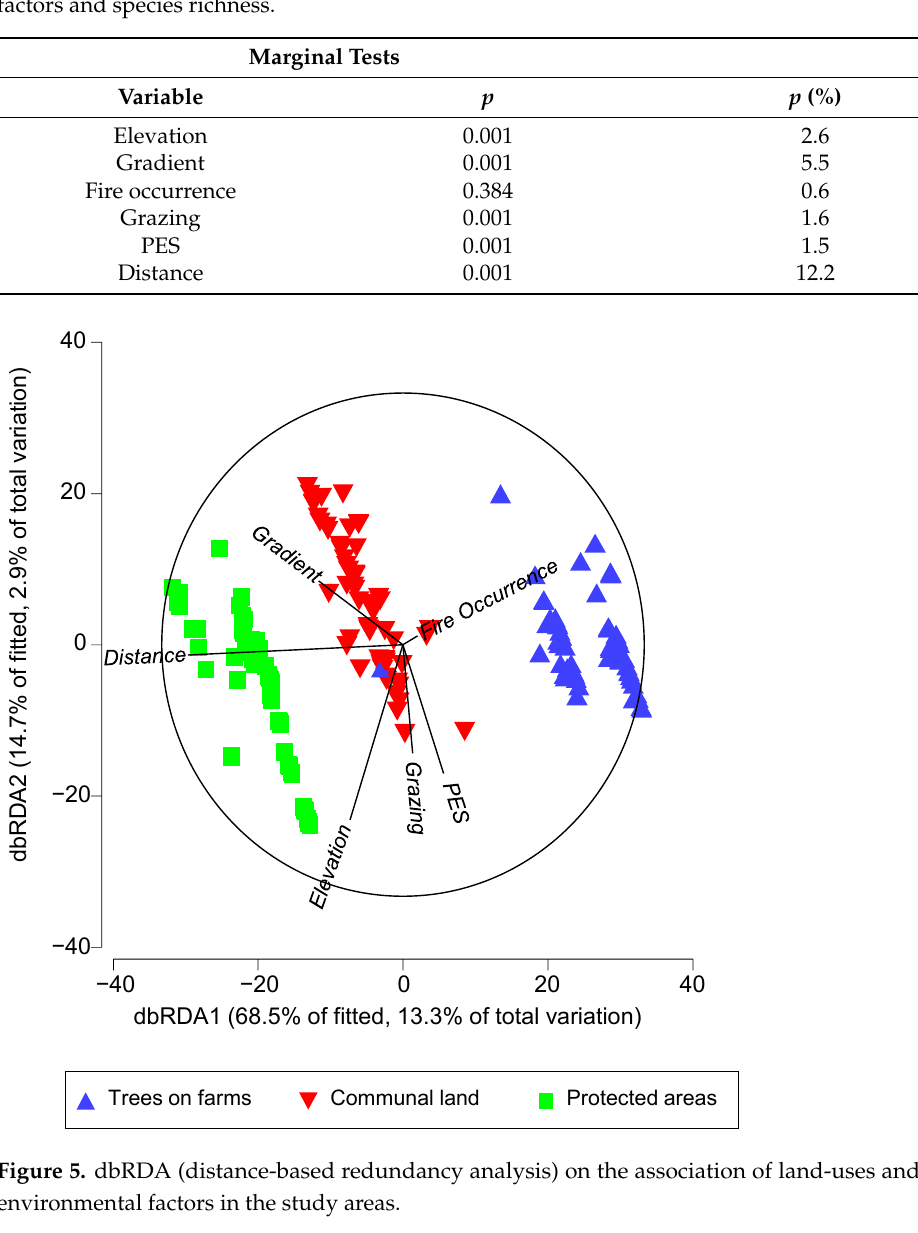
Table 5. Results of the DISTLM Marginal test for relationships between individual socio-ecological factors and species richness.